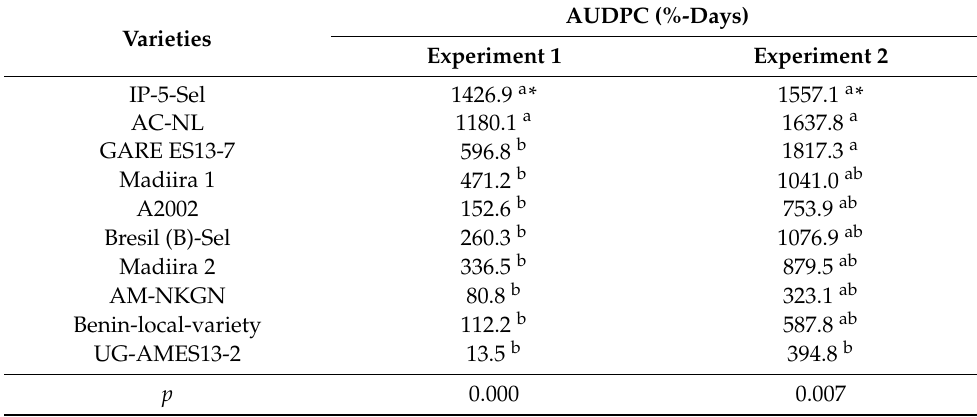
Table 6. Area under disease progress curve (AUDPC) for uncut amaranth plants in the field.